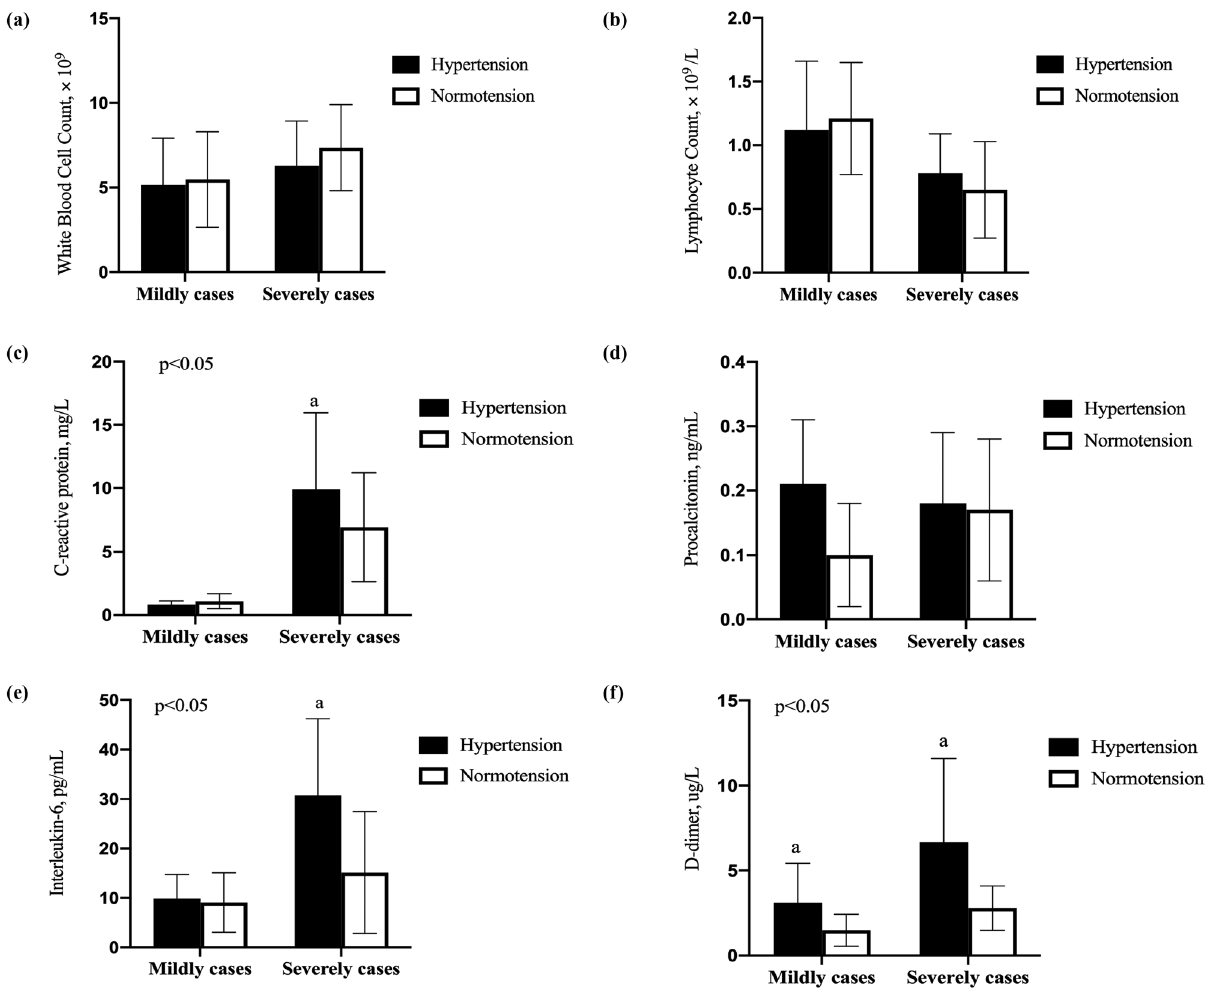
Figure 1: Comparison of laboratory data between the hypertensive and normotensive groups infected with SARS - CoV - 2. The level of WBC ( a ) , Lymphocyte ( b ) , CRP ( c ) , PCT ( d ) , IL - 6 ( e ) , D – D ( f ) between hypertension and normotension with di ff erent severity of